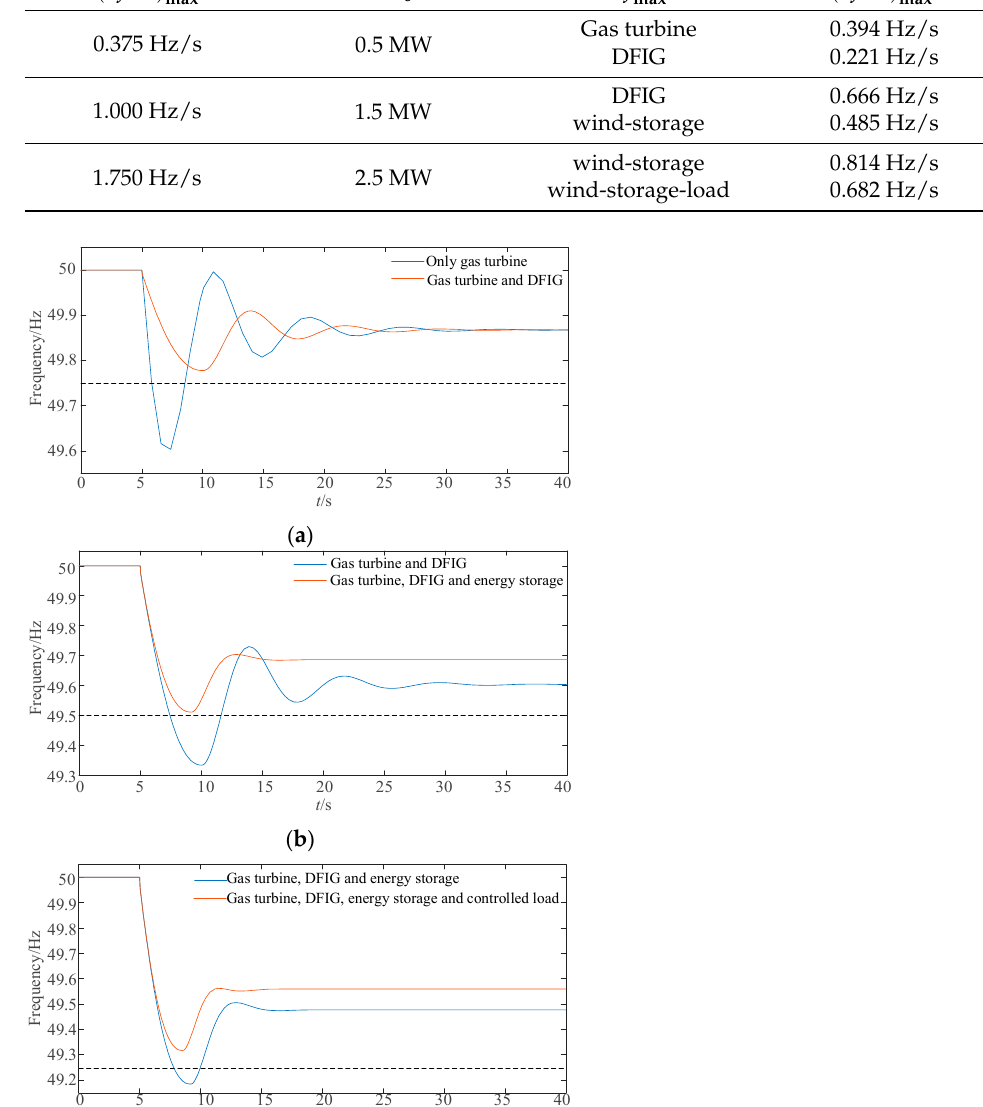
predictionTraditional hierarchical control Hierarchical control based on model